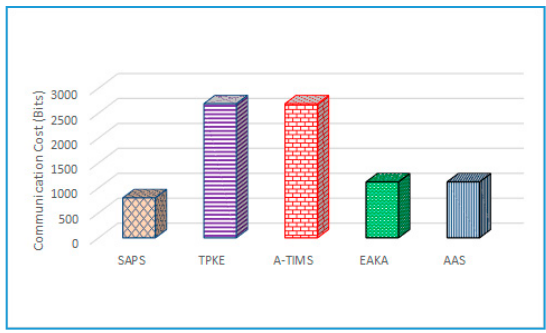
Figure 5. Communication overheads during authentication.